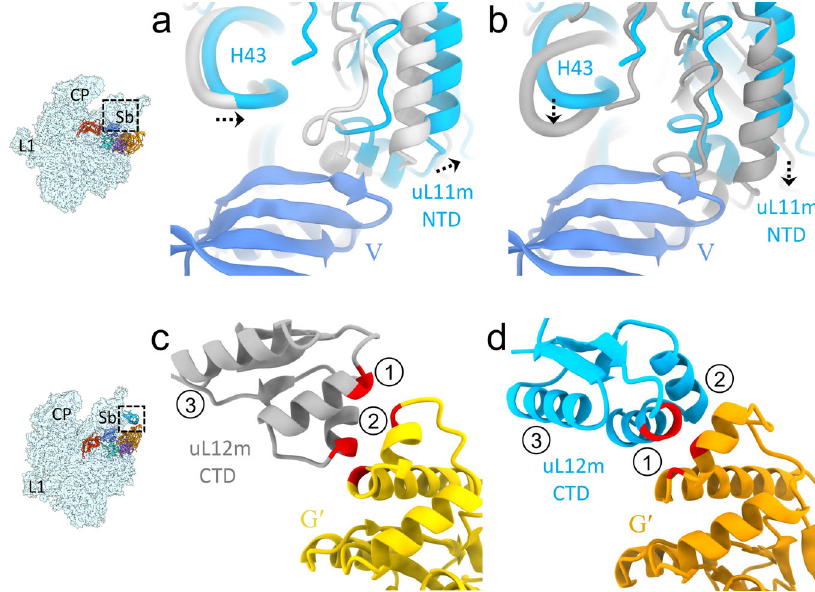
Fig. 5 EF-G2 mt binding induces large-scale conformational changes in the uL11m stalk-base region and the CTD of uL12m. a In the 39S • RRF mt • EF-G2 mt complex, the uL11m stalk-base region (blue) moves towards the CTD of uL12m and away from the domain V of EF-G2 mt , as compared to its position in the EF-G2 mt -unbound 55S mitoribosome (light gray) 3 . b In sharp contrast, in the presence of EF-G1 mt , the uL11m stalk-base region was found to move towards the domain V of EF-G1 mt in the translocation complex (dark gray) 6 . c In the 55S • EF-G1 mt complex 6 , the CTD of uL12m (gray) is positioned in such a way that its α -helices 1 and 2 directly interact with the G ′ subdomain of EF-G1 mt (yellow). d In our 39S • RRF mt • EF-G2 mt complex, the CTD of uL12m (blue) is rotated by about 60° and shifted away by about 7 Å from the G ′ subdomain of EF-G2 mt , resulting in the loss of contacts between its α -helix 2 and G ′ subdomain of EF-G2 mt while a new set of interactions is formed between its α -helix 1 and G ′ subdomain of EF-G2 mt . Thumbnails to the left depict an overall orientation of the 39S subunit (semitransparent blue), and overlaid positions of the ligands. Landmarks on the thumbnail: CP central protuberance, Sb stalk base, L1 MRP